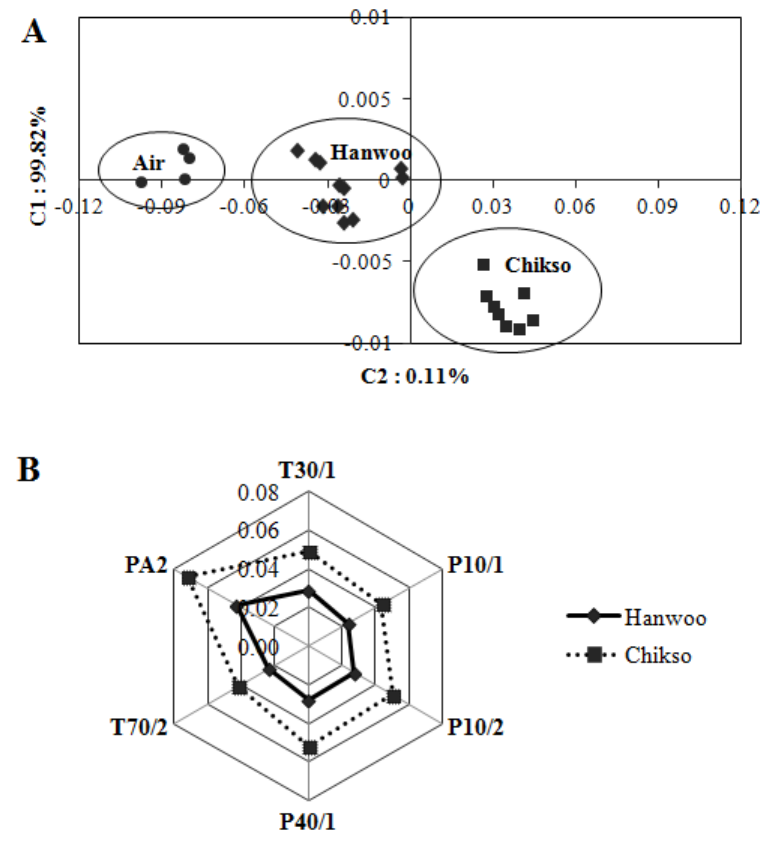
Figure 1. Principal component analysis of aroma pattern of roasted strip loin from Hanwoo and Chikso steers (A) and the resistance ratio of six metal oxide sensors determined using an electronic nose